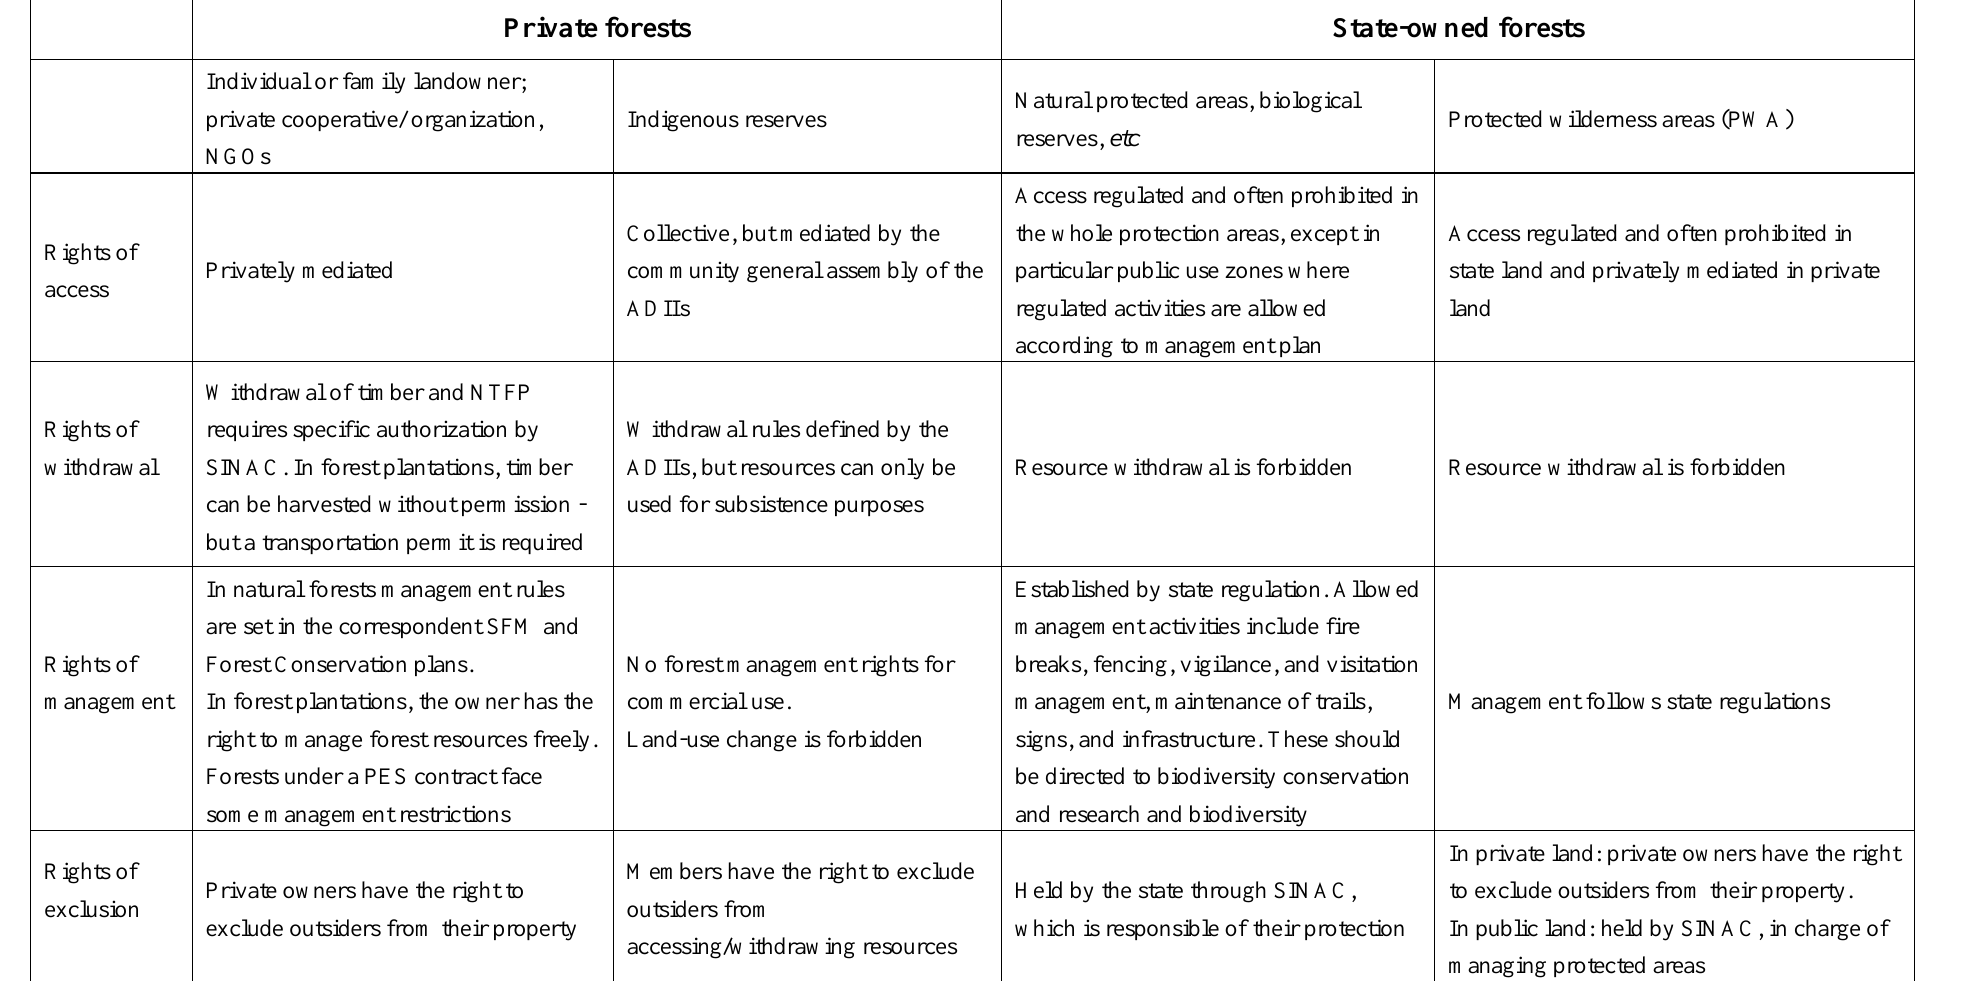
Table 5. Forest tenure systems in Costa Rica—―Bundles of rights‖ and implications for REDD+ design and